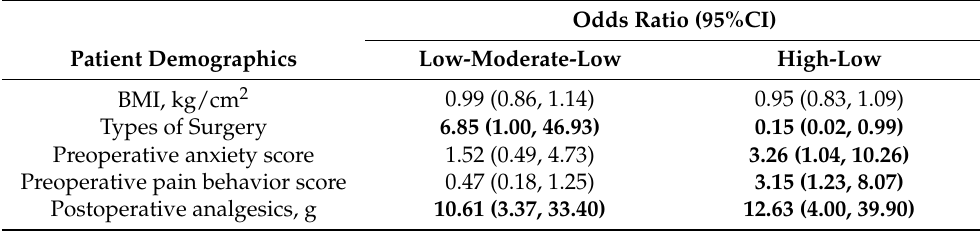
Table 4. Results from multinomial logistic regression. The low-pain group was used as the reference group for trajectory results. The odds ratio is used to represent the odds ratio of the similarity of group members per unit increase. The bold parameter represents the odds ratio of 95% CI excluding